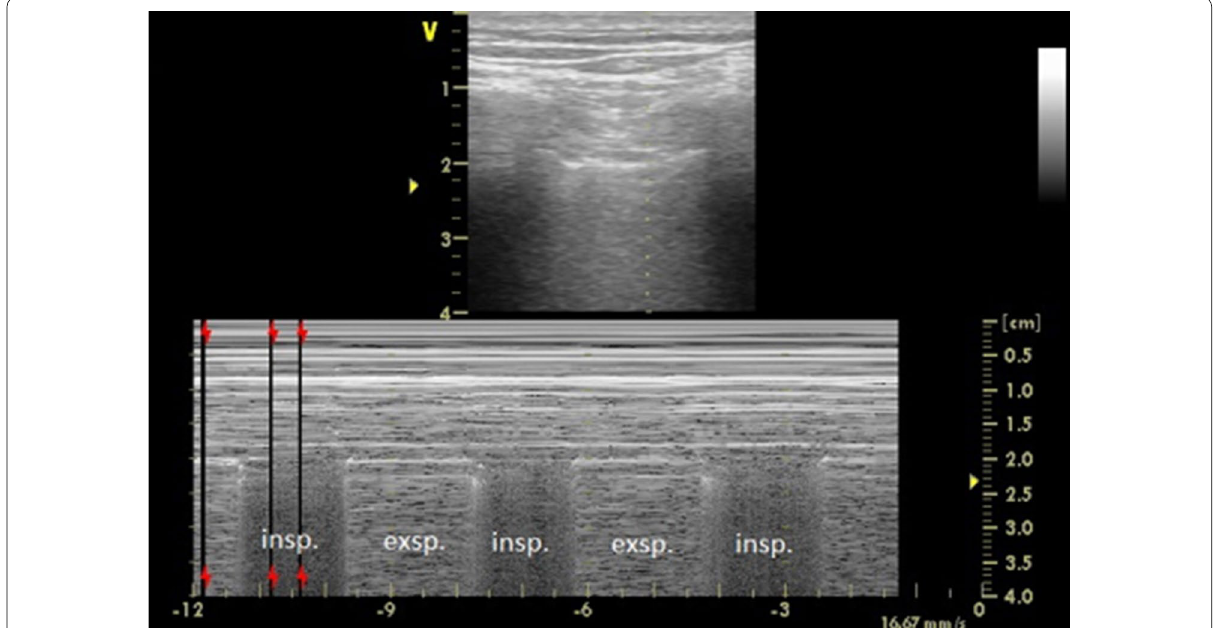
Fig.5 M-mode (linear transducer) during a respiratory cycle in anterior axillary line confirming ventral pneumothorax in a patient with low CDI. There is a bat sign of two ribs with the intercostal space between them. The seashore sign in inspirium changes with a pneumothorax (barcode sign) in exspirium (Fig.